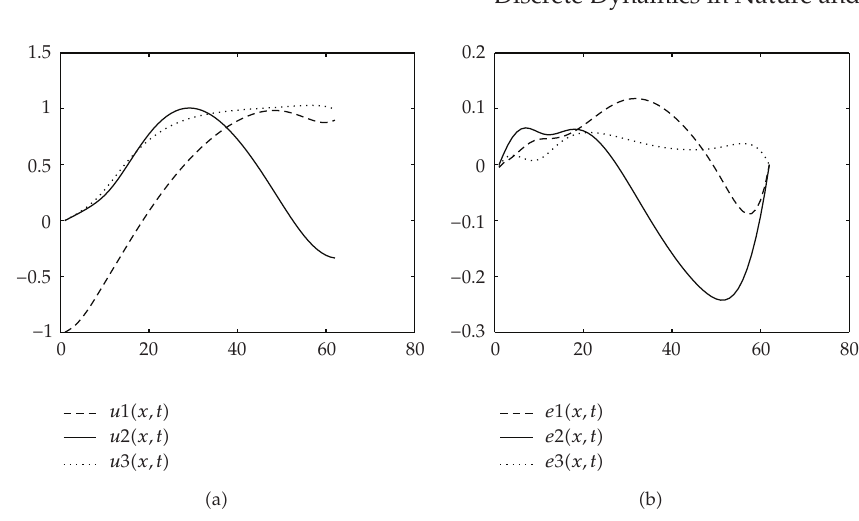
Figure 4: (cid:3) a (cid:4) Solution of u at t (cid:7) 0 . 3, (cid:3) b (cid:4) error of u at t (cid:7) 0 . 3; k (cid:7) 0 . 0001 ,h (cid:7) 1 / 5.